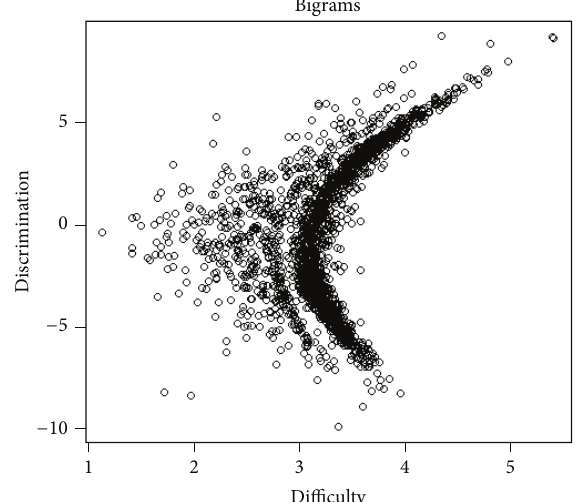
Figure 4: Term frequency of the corpus.